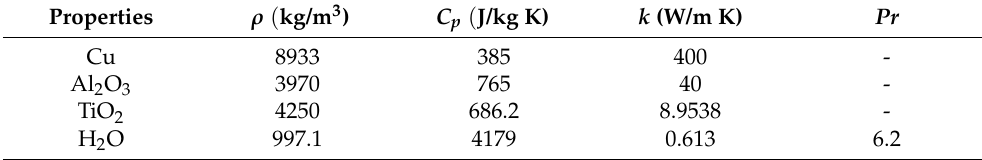
Table 1. Thermal and physical characteristics for nanoparticles (see Oztop and Abu Nada [48]). Properties ρ ( kg/m 3 ) C p ( J/kg